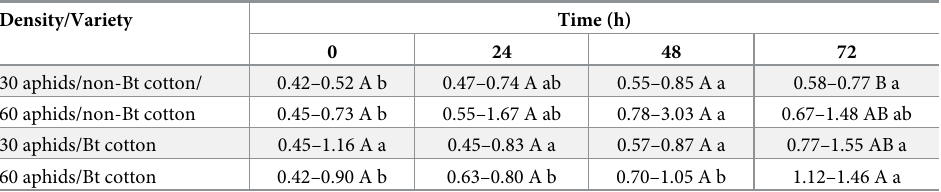
Uppercase letters compare averages within each column. and lowercase letters compare averages within each row. Means followed by the same letters do not differ from each other by overlapping confidence intervals generated by Boostrap ( P <